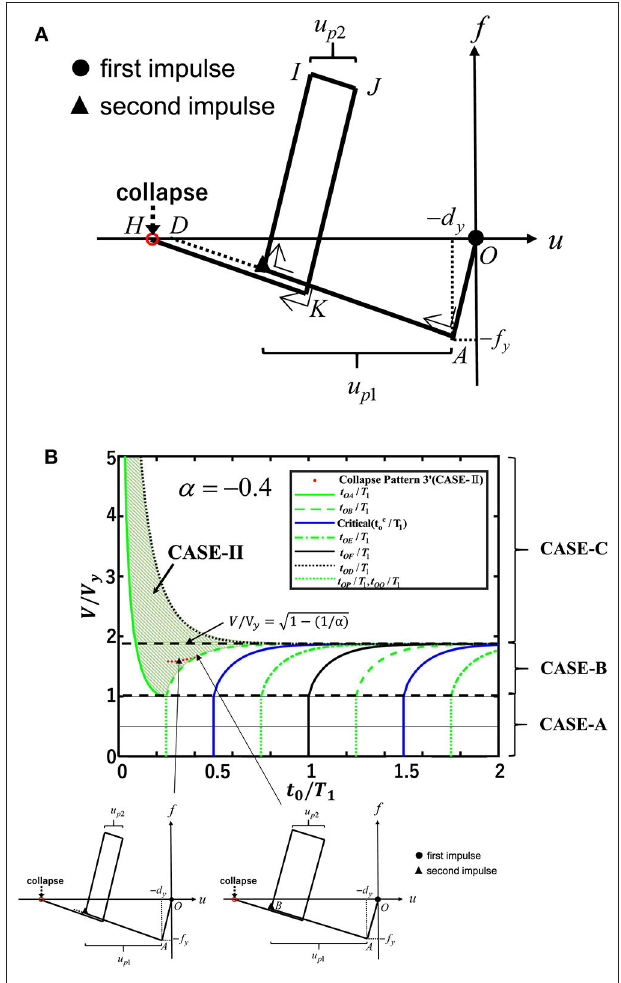
FIGURE 6 | Collapse pattern 3 ′ (CASE-B and CASE-II). (A) Restoring-force characteristic. (B) Second impulse timing t 0 / T 1 -input velocity relation.